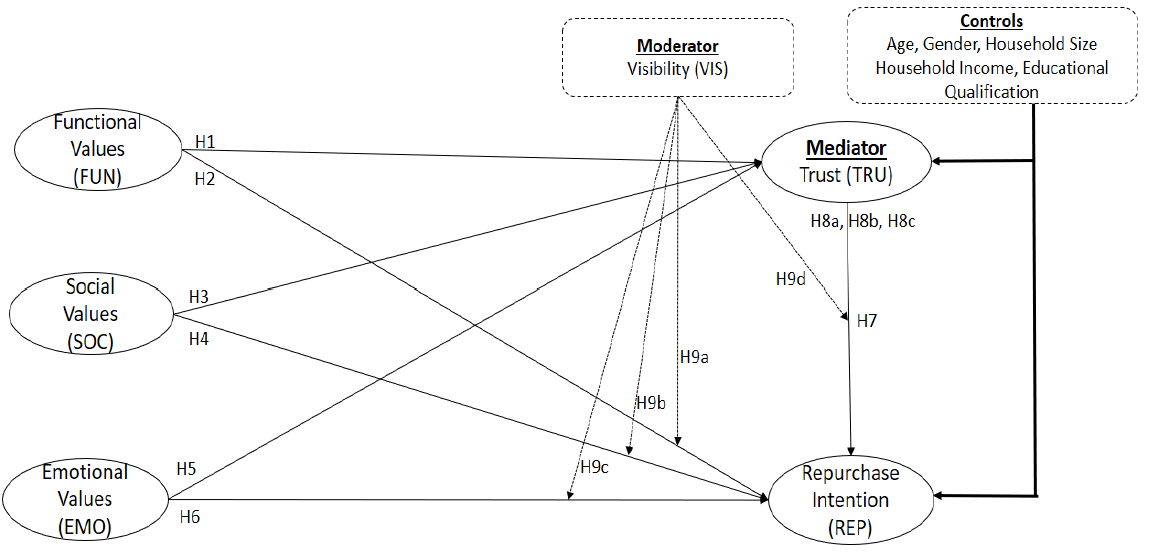
Figure 1. Hypothesized research model.